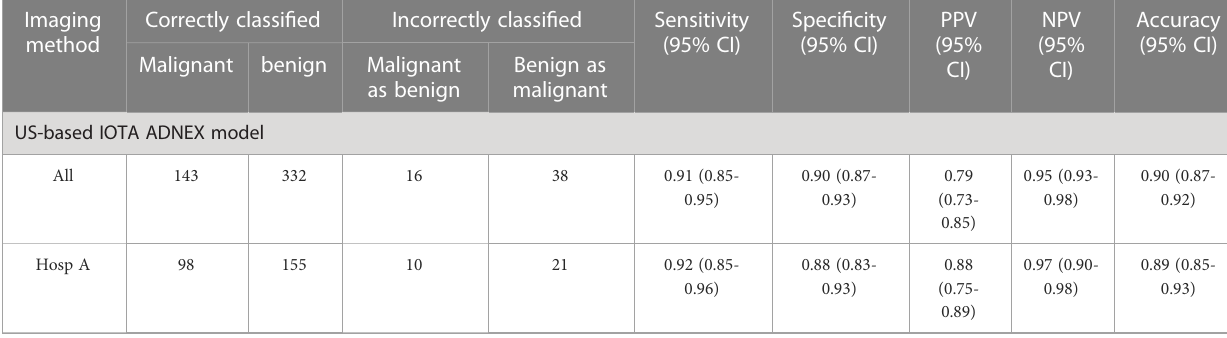
TABLE 3 Comparison of the diagnostic performances of the ADNEX model and subjective MRI assessment.